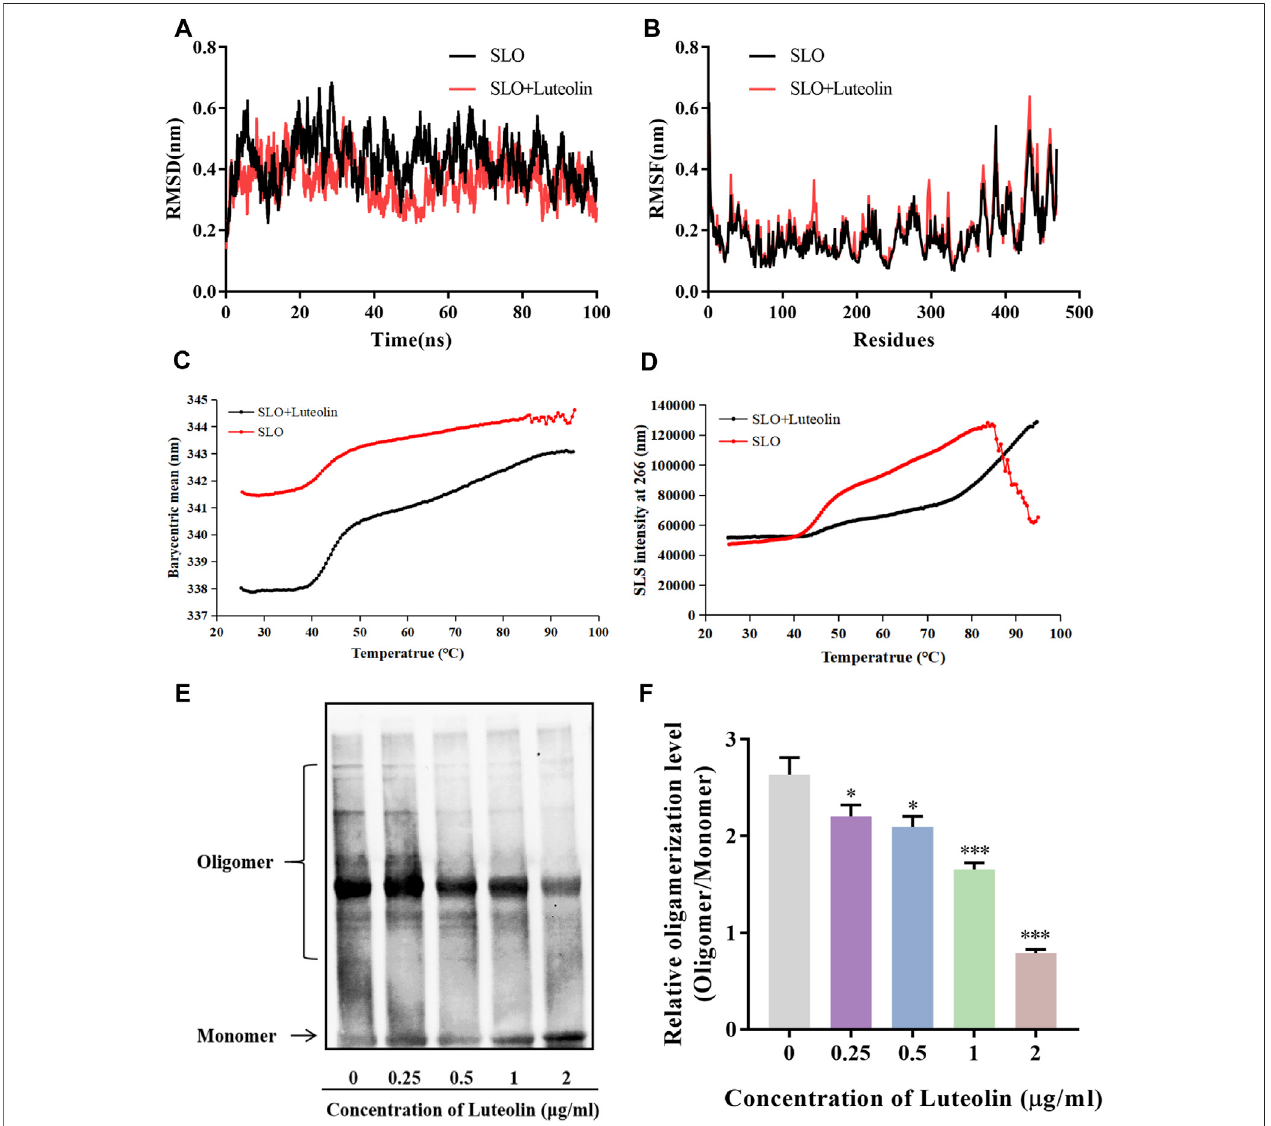
FIGURE3| InteractionsofSLOwithluteolinandeffectsofluteolinontheproteinstructureandstabilityoftheSLOprotein. (A,B) TheRMSDandRMSFvaluesofthe backboneatomsintheluteolin-SLOcomplex(redline)andthesystemcontainingonlytheSLOprotein(blackline)duringtheMDprocedure. (C,D) Thebarycentric mean (BCM) indicates the protein folding state, thermal stability of protein vs. protein-ligand complex, measured by static light scattering (SLS). (E) Western blot analysis of luteolin ’ s effect on the oligomerization of SLO. (F) Quantitative densitometric analysis of the oligomerization level (oligomer/monomer) was performed using NIH ImageJsoftware (GEHealthcareLifeSciences, United Kingdom),withdataarepresentedasmean±SD (One-way ANOVA)foreach group ( n =3),* p < 0.05;** p < 0.01; *** p < 0.001 versus positive control.